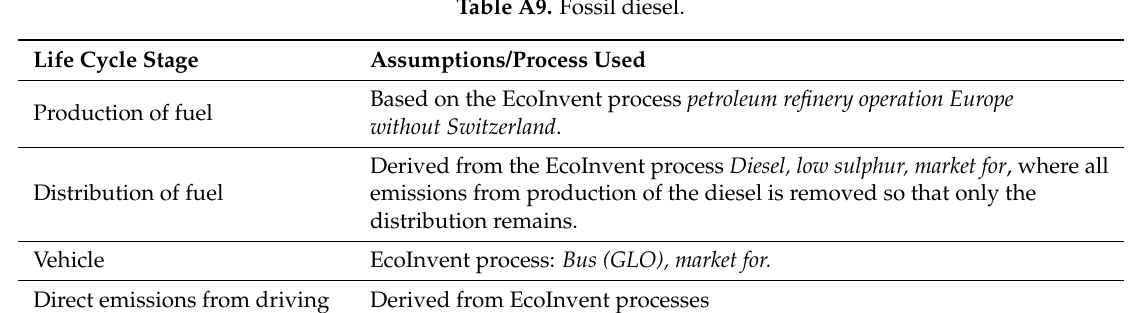
Table A9. Fossil